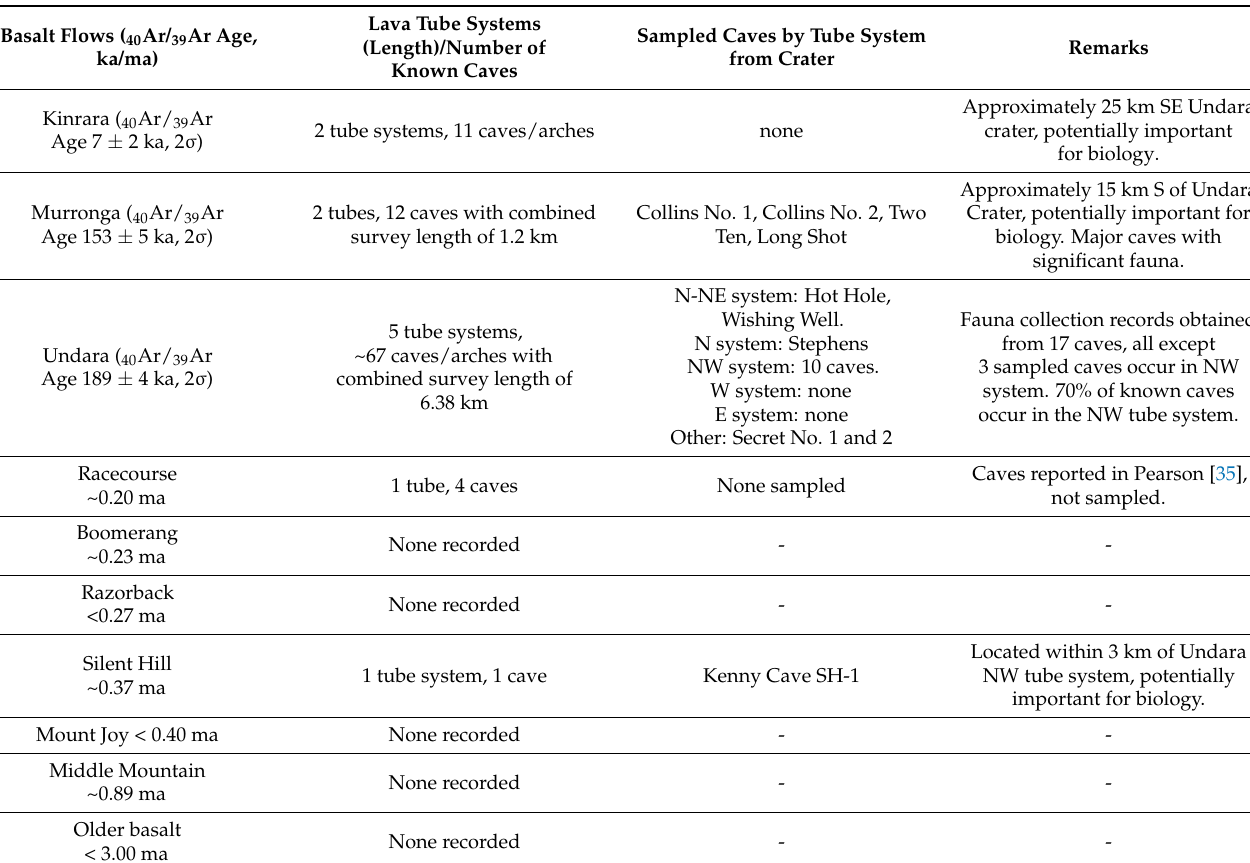
Table 1. McBride Province basalt flows (youngest to oldest) and a synopsis of their recorded lava tube systems and caves (where known) including caves which have been sampled for fauna. Geological information from [35,38,40] and 40 Ar/ 39 Ar ages (ka/ma) from [39]; biological information compiled from [1,29,30,32–34]. Lava Tube Systems Basalt Flows ( 40 Ar/ 39 Ar Age, Sampled Caves by Tube System (Length)/Number of ka/ma) from Known Caves